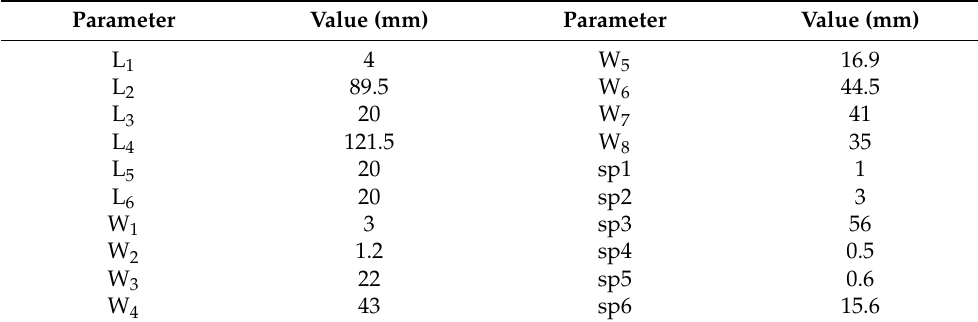
Figure 8. Simulation results of ( a ) the reflection and transmission coefficient (S 11 and S 21 , respectively) of the proposed FSS unit cell and ( b ) gain results comparison after incorporation with FSS unit cells. Table 1. Geometrical parameters of the proposed